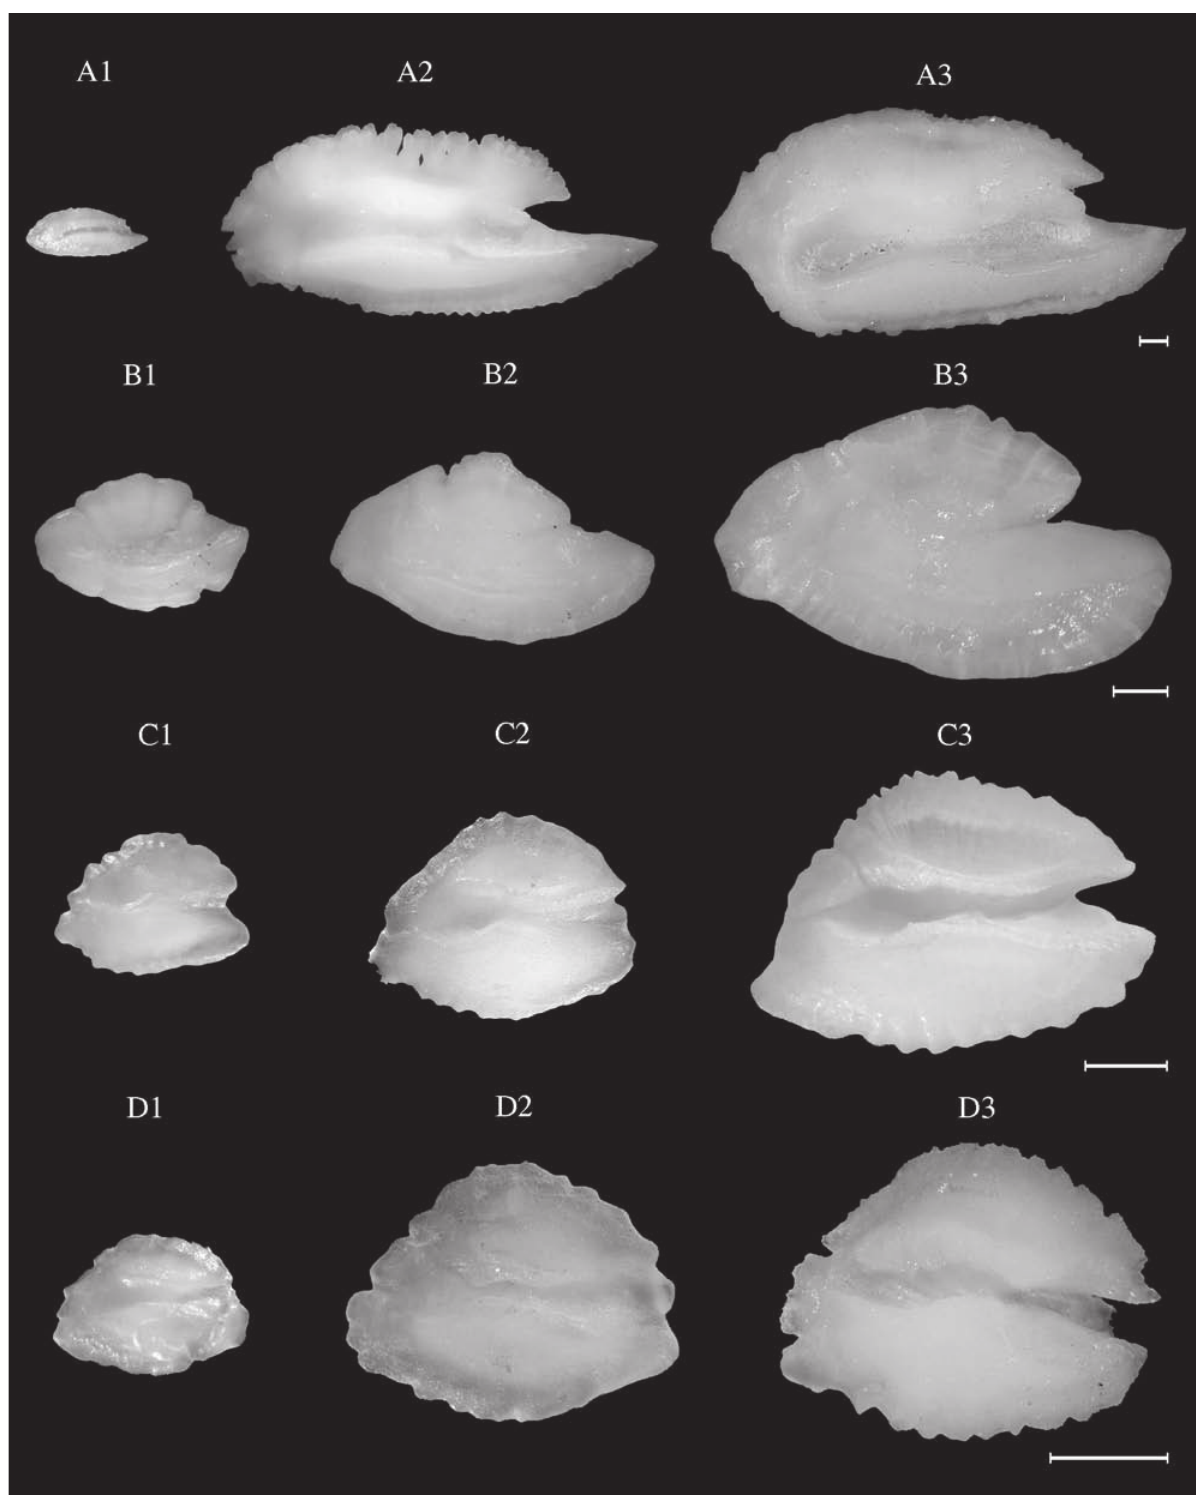
Fig. 43. – Scorpaena scrofa . TL: A1, 8.0 cm (WM); A2, 45.8 cm (NEA); A3, 45.0 cm (CEA). Setarches guentheri (CEA). TL: B1, 7.7 cm; B2, 11.5 cm; B3, 17.5 cm. Aspitrigla cuculus . TL: C1, 9.5 cm (WM); C2, 16.5 cm (WM); C3, 29.2 cm (NEA). Chelidonichthys obscurus . TL: D1, 9.0 cm (WM); D2, 19.0 cm (NEA); D3, 24.3 cm (CEA). Scale bar = 1